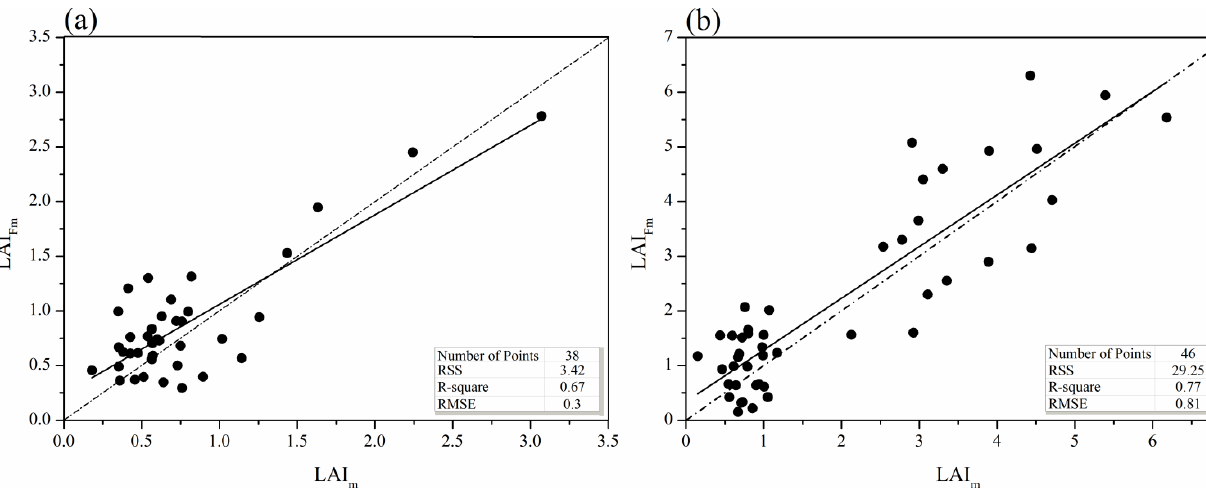
Figure 8. Results of LAI F compared to LAI r in early July ( a ) and late August ( b )